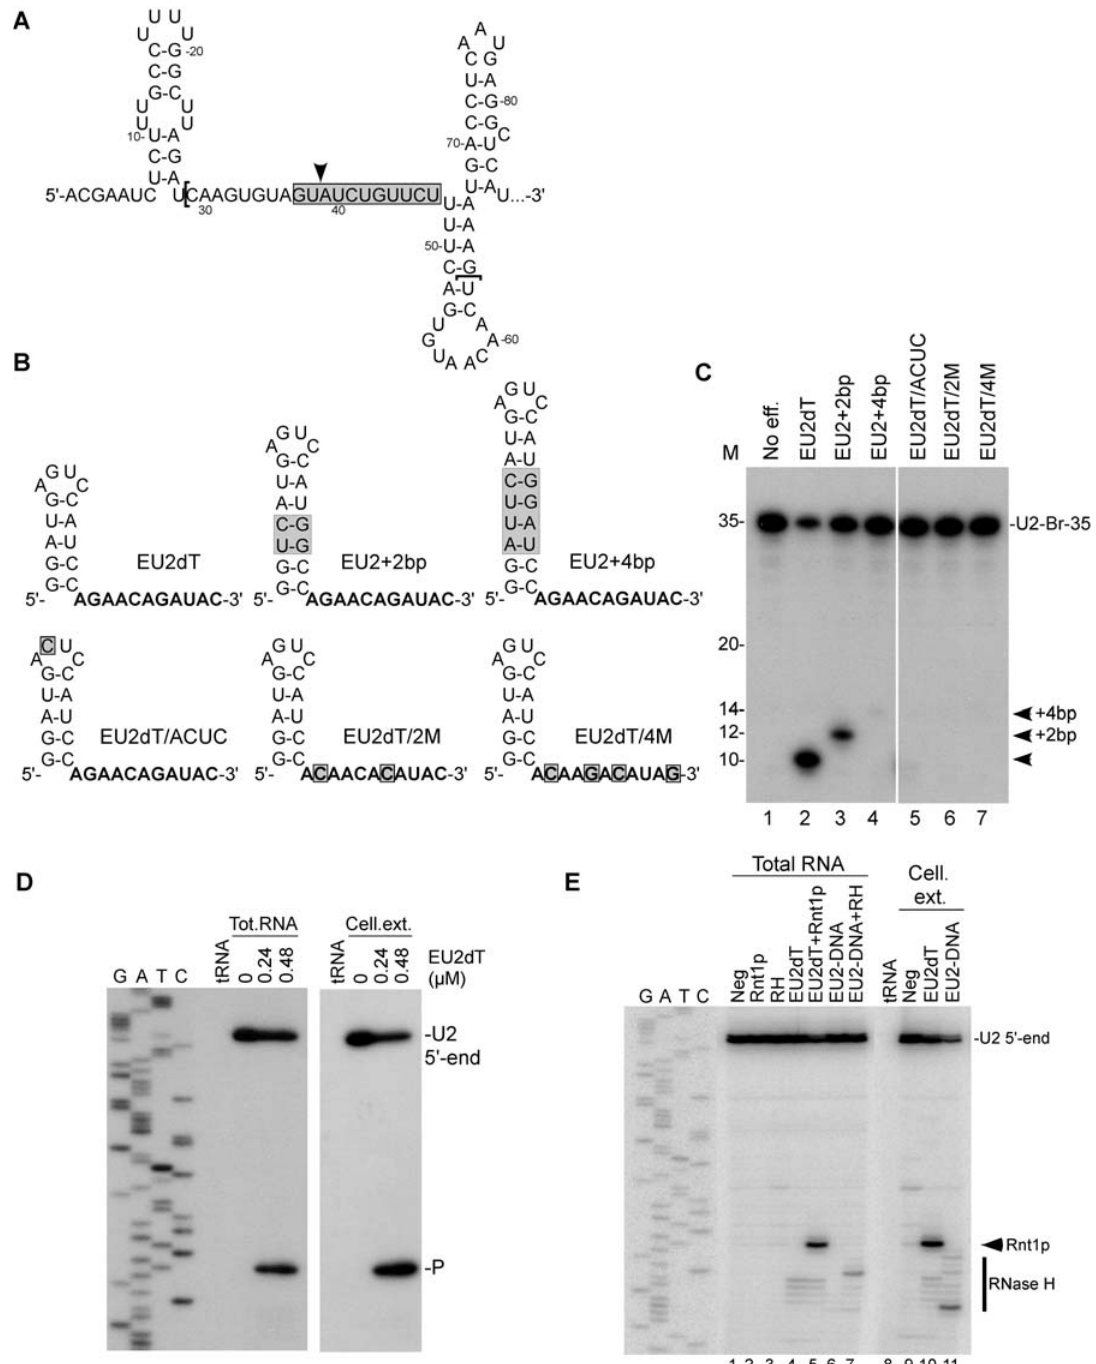
Figure 5. Guide RNA directs sequence specific cleavage in a natural RNA sequence. (A) Secondary structure of the U2 snRNA branch site region (nucleotides 1 to 86). The gray box, the arrowhead and the brackets represent respectively the targeted region by Rnt1p, the anticipated cleavage site by Rnt1p and the region used for in vitro cleavage assays (U2-Br-35). (B) Sketches representing the secondary structure of guides recognized by Rnt1p and complementarity to the U2 branch site. Sequences in bold represent the nucleotides complementary to the U2 target. The gray boxes indicate mutations relative to the control (EU2dT). (C) In vitro cleavage of 5 9 -end labeled U2-Br-35 with Rnt1p and the different RNA guides. The cleavage reactions were performed in RNA excess with a guide/target ratio of 1:1. The positions of the cleavage products are indicated on the right and the RNA marker is displayed on the left. (D) Total yeast RNA and recombinant Rnt1p or yeast cell extract prepared from strain YHM111-U2L2 were used to analyze Rnt1p-directed cleavage using EU2dT. Primer complementary to the 3 9 -flanking sequence of the U2 snRNA branch site was extended on the extracted RNA to map the cleavage site. The reference DNA sequence produced using the same primer is shown on the left. The product corresponding to the cleaved RNA and the U2 5 9 -end are indicated on the right. Bacterial tRNA was used as negative control for the primer extension. (E) Cleavage comparison between Rnt1p and RNase H in total RNA or cell extract prepared from yeast YHM111-U2L2. The cleavage specificity was determined by primer extension. The reference DNA sequence produced using the same primer is shown on the left. The RNA guide and the DNA oligo used with RNase H targeted the same nucleotides. The positions of Rnt1p and RNase H cleavage products and the U2 5 9 -end are indicated on the right. doi:10.1371/journal.pone.0000472.g005 PLoS ONE |